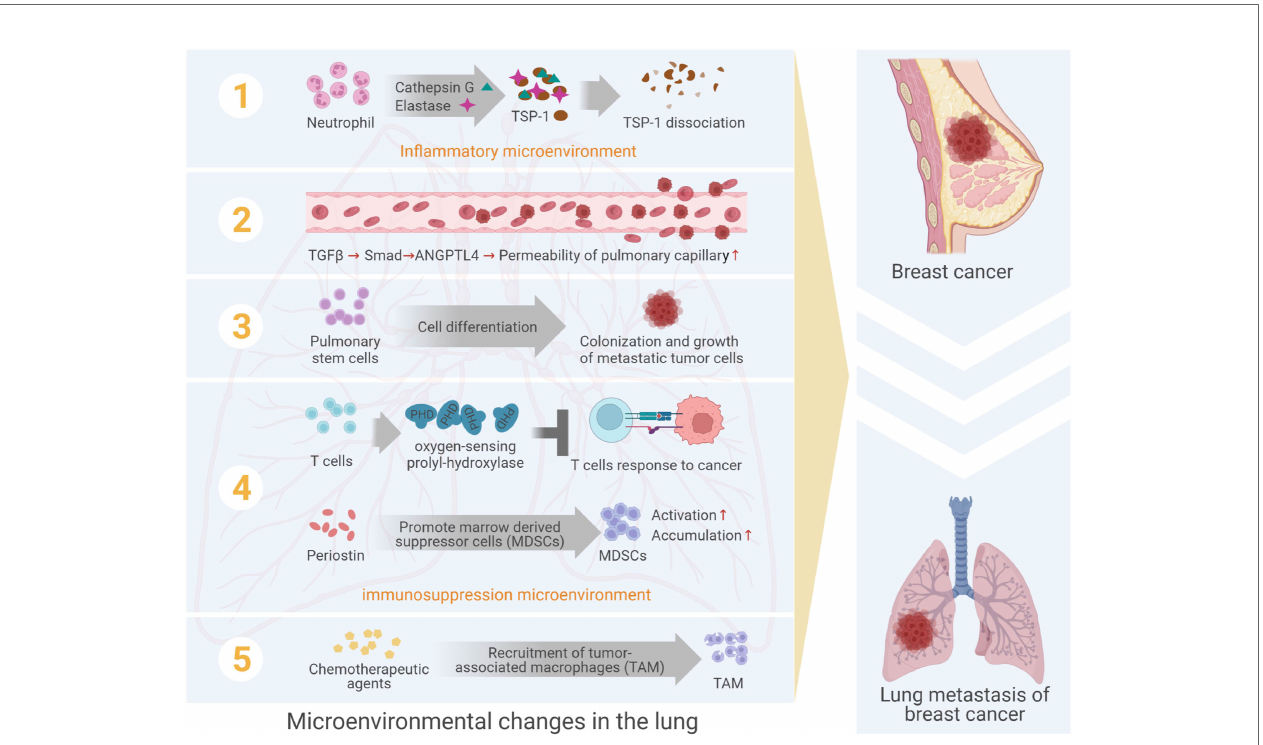
FIGURE 1 | The formation of pulmonary microenvironment in lung metastasis from breast cancer. The formation of sites adapted to the survival of metastatic cancer cells is regulated by acellular components and a variety of cells, including neutrophils, vascular endothelial cells, stem cell-like lung cells, immune cells,